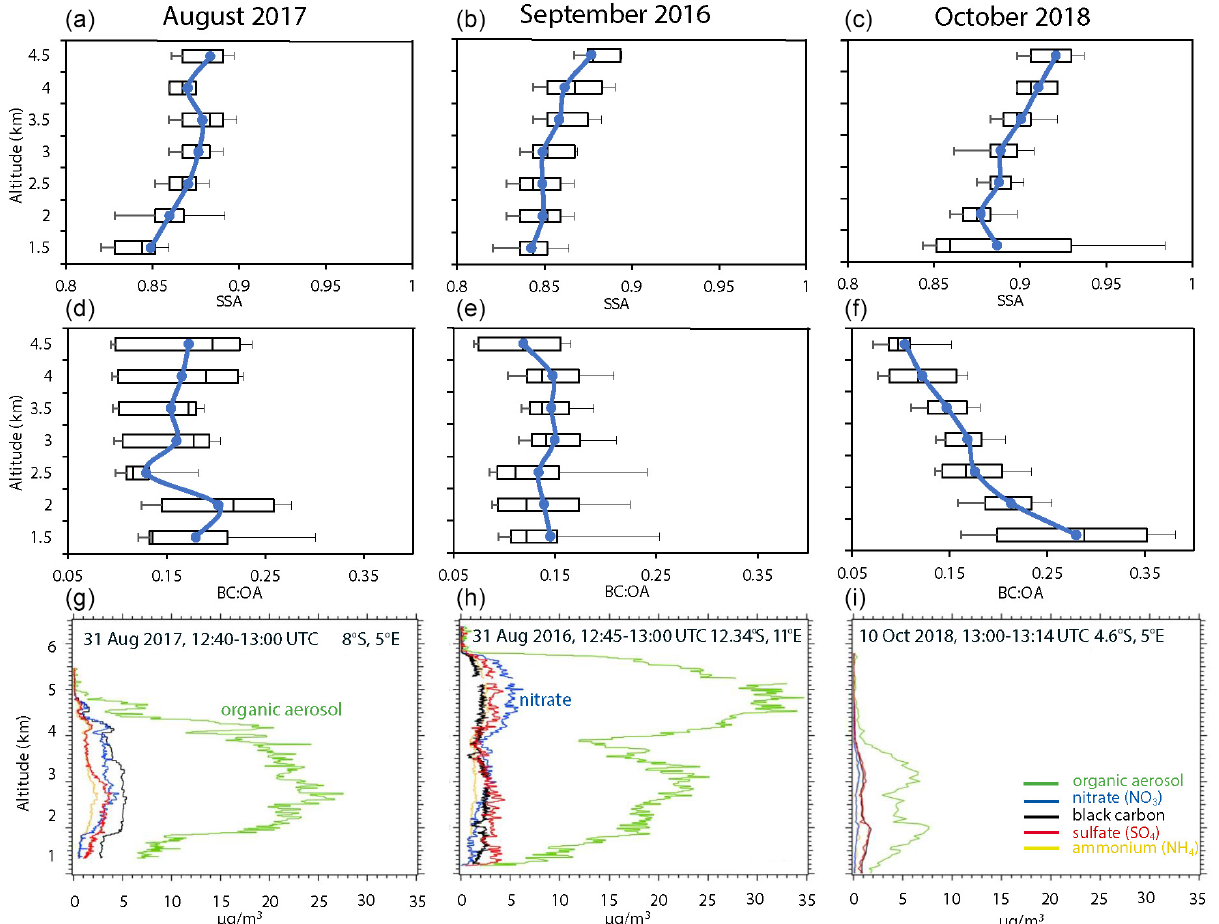
Figure 14. (a–c) Deployment-mean 530nm SSA vertical profiles for each year for the August (2017), September (2016), and October (2018) deployments. (d–f) The corresponding mean black carbon to organic aerosol ratio (BC : OA) profiles. (g–i) Example profiles of individual aerosol species, from left to right: 30 August 2017, 12:40–13:00UTC, 8 ◦ S/ ◦ E; 24 September 2016, 12:45–13:00UTC, 12.34 ◦ S/11 ◦ E; and 4 October 2018, 13:00–13:15UTC, 4.6 ◦ S/5 ◦ E. A blue line connects mean values, with box–whisker plots indicating the 10th, 25th, 50th, 75th, and 90th percentile values.